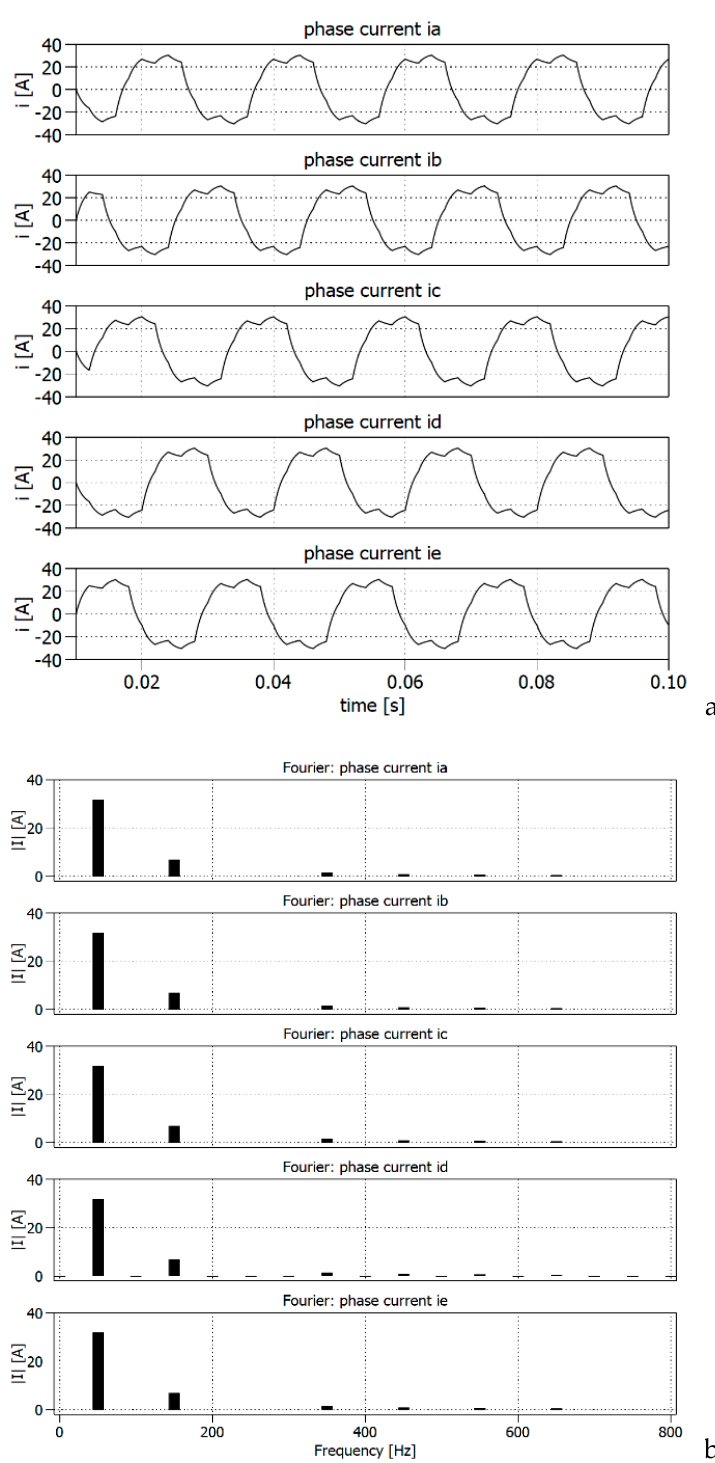
Figure 16. The phase electrical currents: 𝑖 (cid:3028) , 𝑖 (cid:3029) , 𝑖 (cid:3030) , 𝑖 (cid:3031) , 𝑖 (cid:3032) , where: ( a ) currents waveforms and ( b ) currents